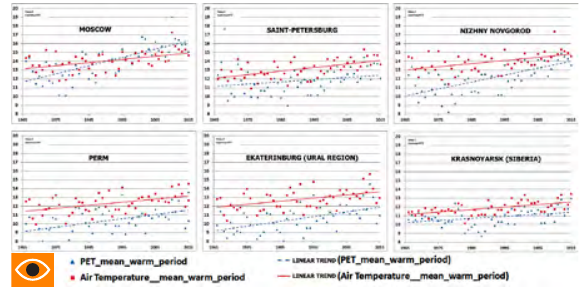
Figure 4. Linear trends of PET-index (annual mean for warm period) and air temperature (annual mean for warm period) in different parts